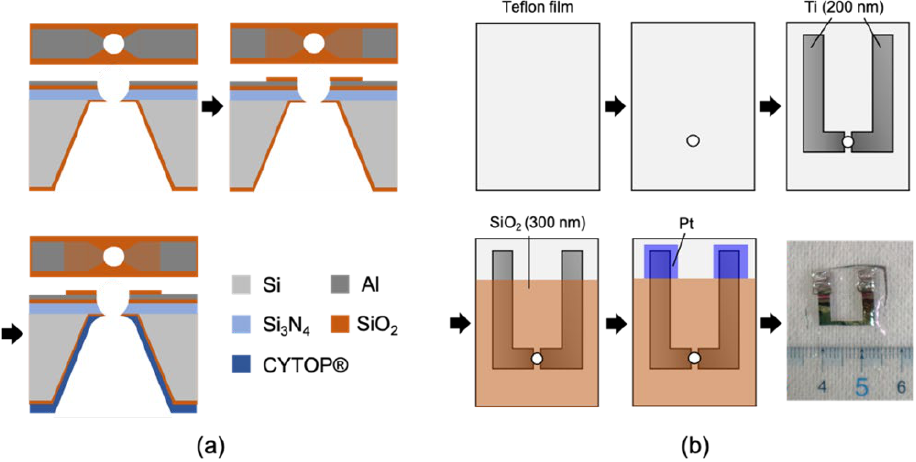
Figure 7. The fabrication process of ( a ) Si chip and ( b ) Teflon film equipped with metal electrodes for lateral voltage application. Reprinted with modification from Refs. [10,11]. Copyright 2019 American Chemistry Society and 2022 The Royal Society of Chemistry.